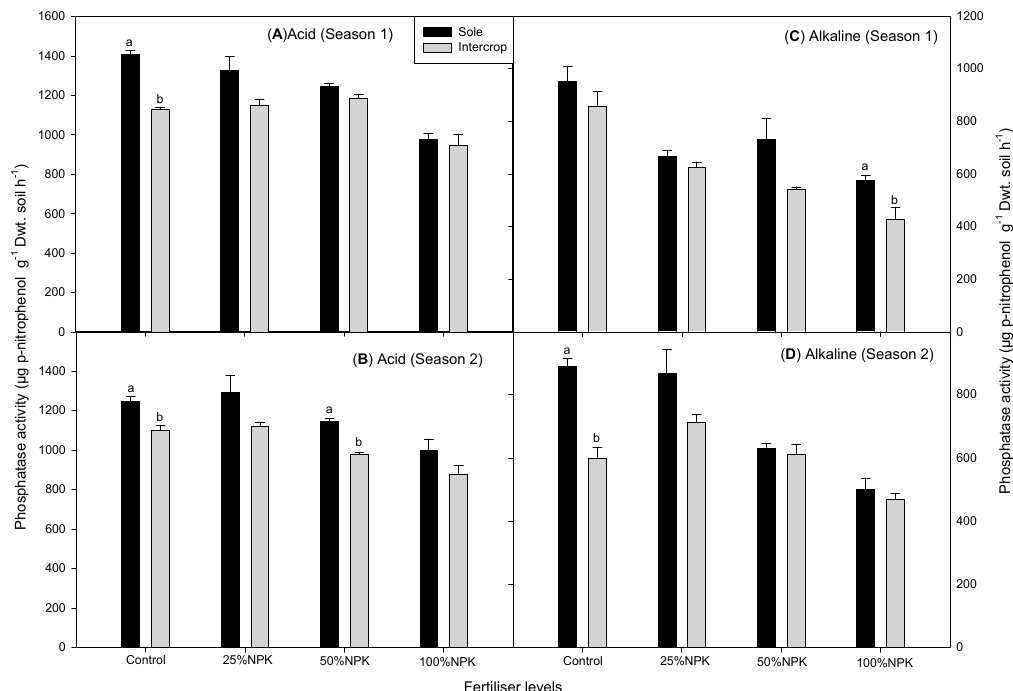
Figure 2. Two-way analysis showing the e ff ects of fertilizer levels and cropping on acid and alkaline phosphatase activity on rhizosphere of cowpea at four NPK levels in ( A , B ) 2014 / 15 and ( C , D ) 2015 / 16 seasons. Each bar represents the mean ± SE (n = 4). Di ff erent letters in each fertilizer treatment shows significant di ff erences at p ≤ 0.05 in sole or intercropping.